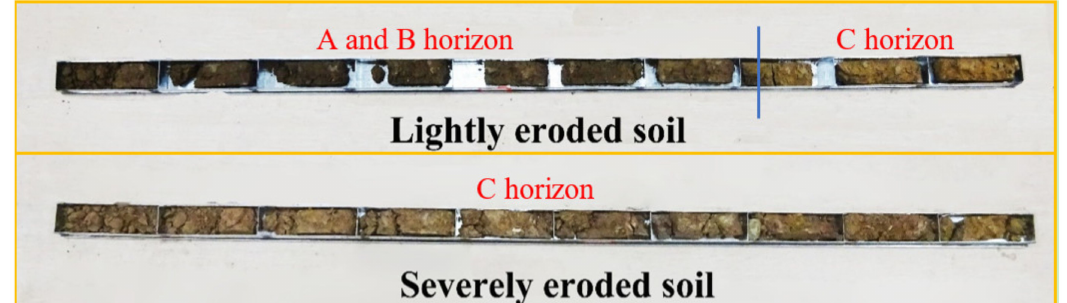
Figure 1. The types of soil profiles for di ff erent eroded soils.